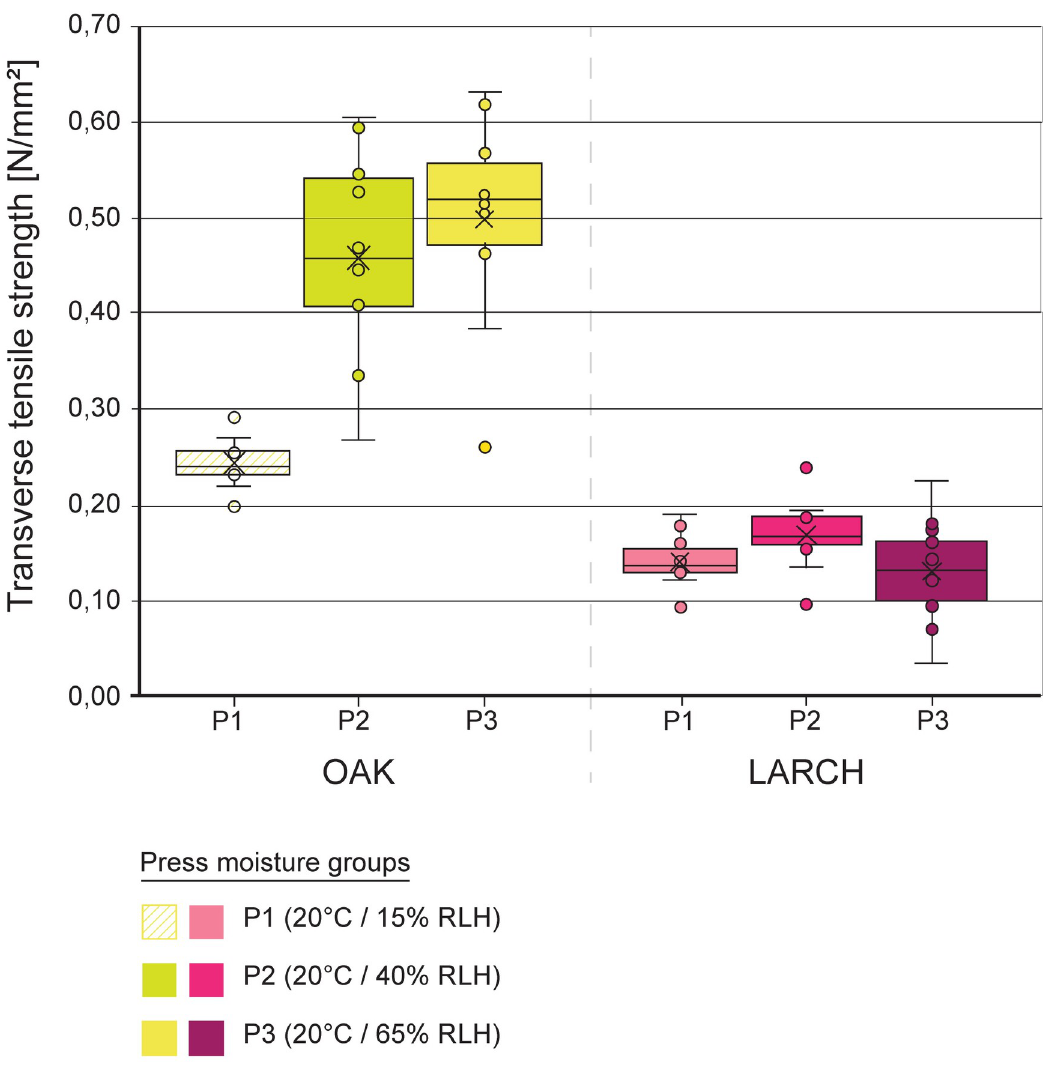
Fig 6. Transverse tensile strengths of the bark panels divided into the press moisture groups P1, P2 and P3 of both bark types. Boxplots with median as middle line and arithmetic mean as cross. The whisker length is a maximum of 1.5 times the interquartile range.